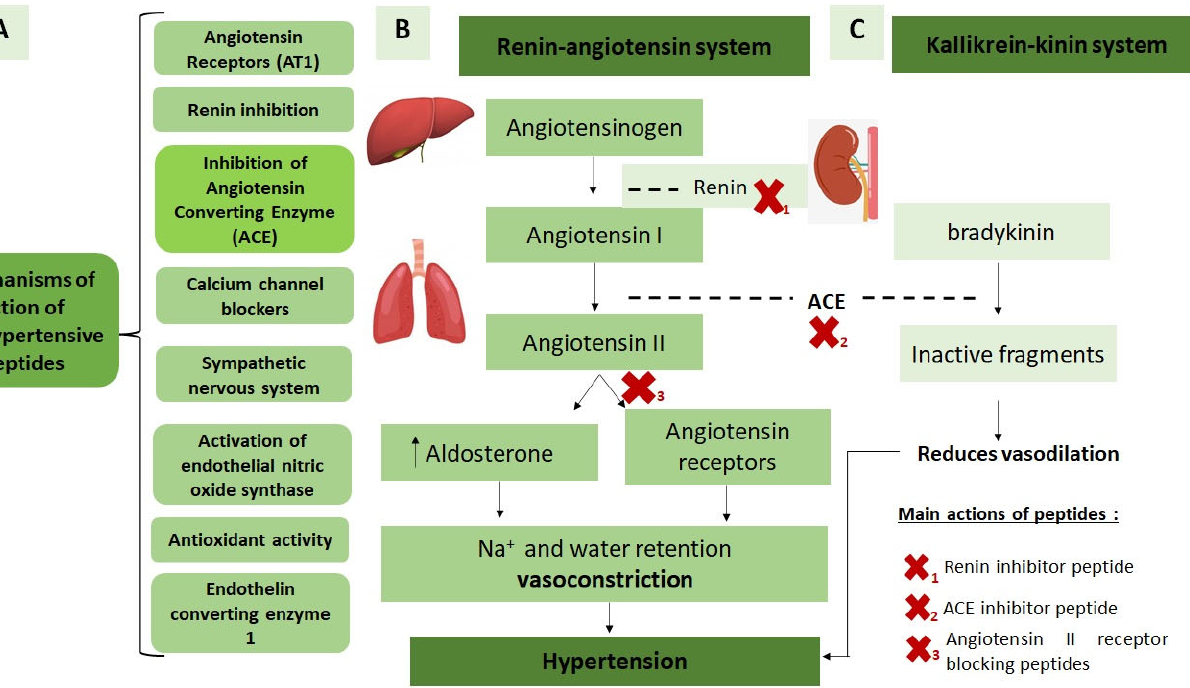
Figure 3. Mechanisms of action of antihypertensive peptides ( A ); regulation of blood pressure by the renin–angiotensin ( B ) and kallikrein–kinin ( C ) systems.